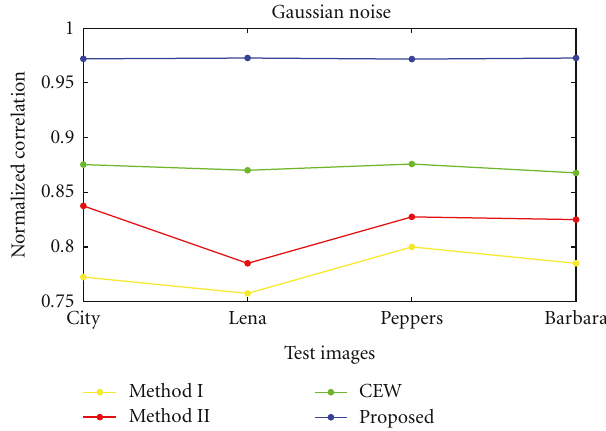
Figure 17: The robustness comparison result of the proposed method with [2, 3] under Gaussian attack (mean,var) = (0, 0 . 0001).